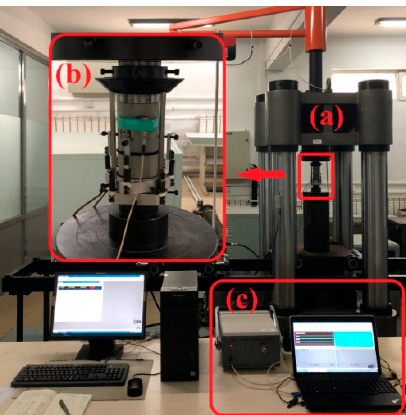
Figure 1. The test system. ( a ) Uniaxial testing machine; ( b ) Extensometer; ( c ) Acoustic emission (AE) monitoring system.